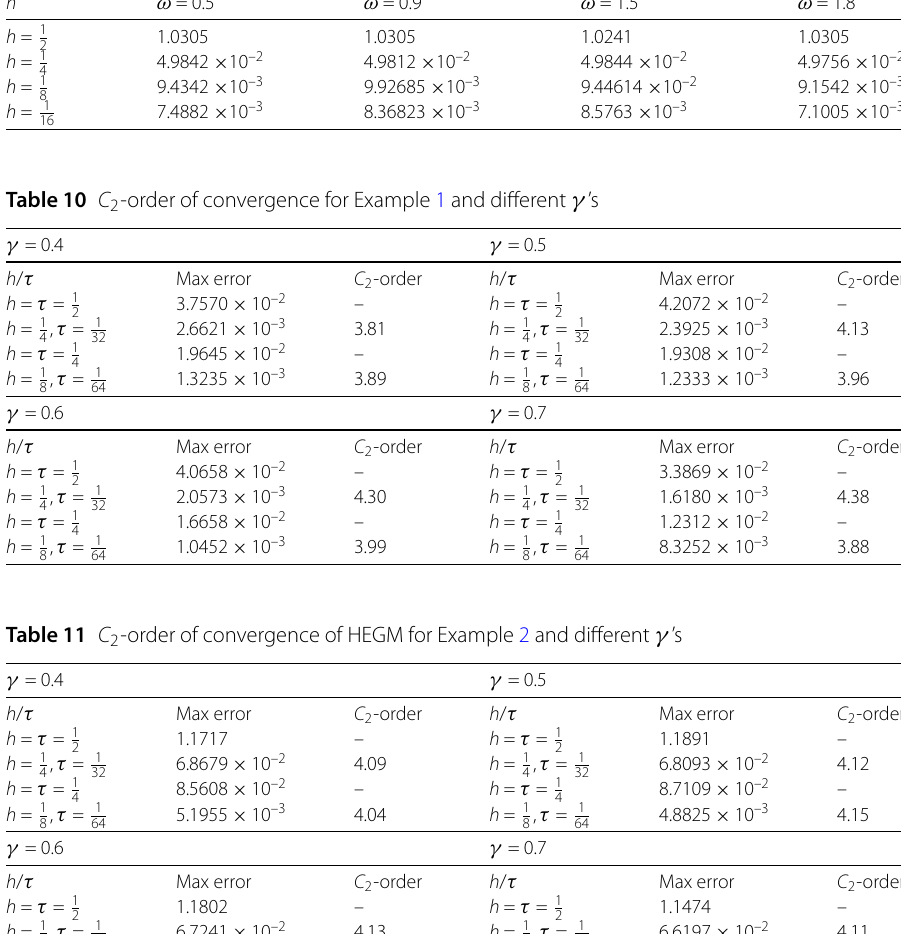
Table 9 Errors and relaxation factor ( ω ) with τ = 1